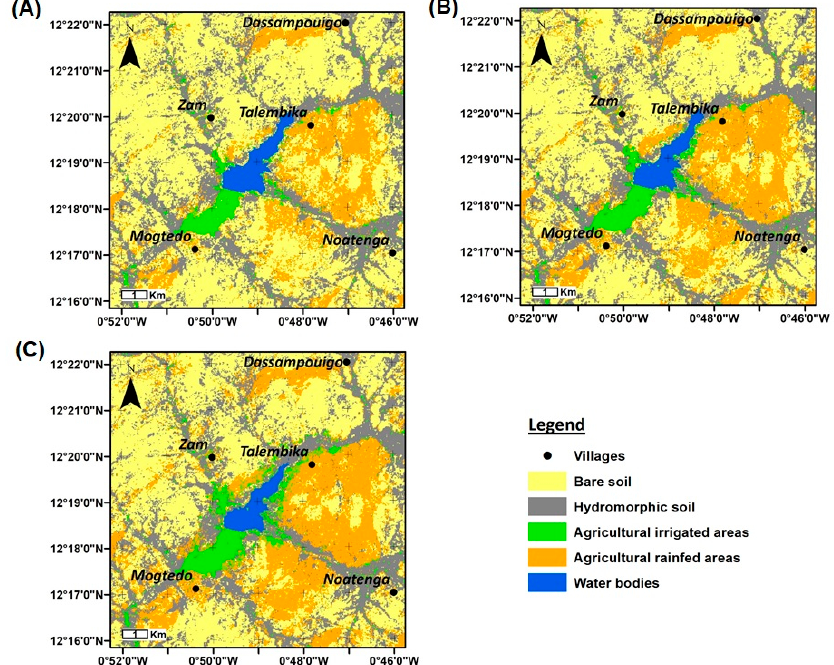
Figure 5. Classification of the different satellite images after pixel trajectory corrections. ( A ) Landsat-5 TM image (15 February 1987); ( B ) Landsat-7 ETM+ image (11 February 2000); ( C ) Landsat-8 OLI image (27 January 2015).